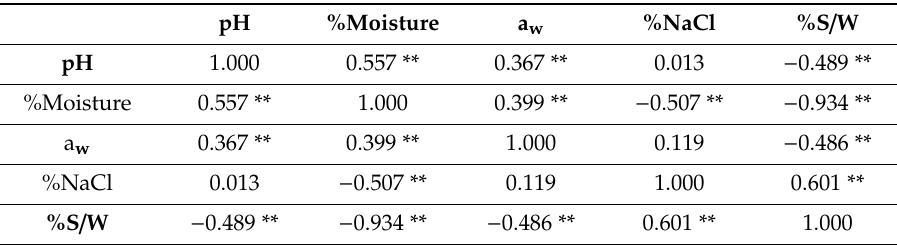
Table 3. Spearman’s correlations among chemical parameters.